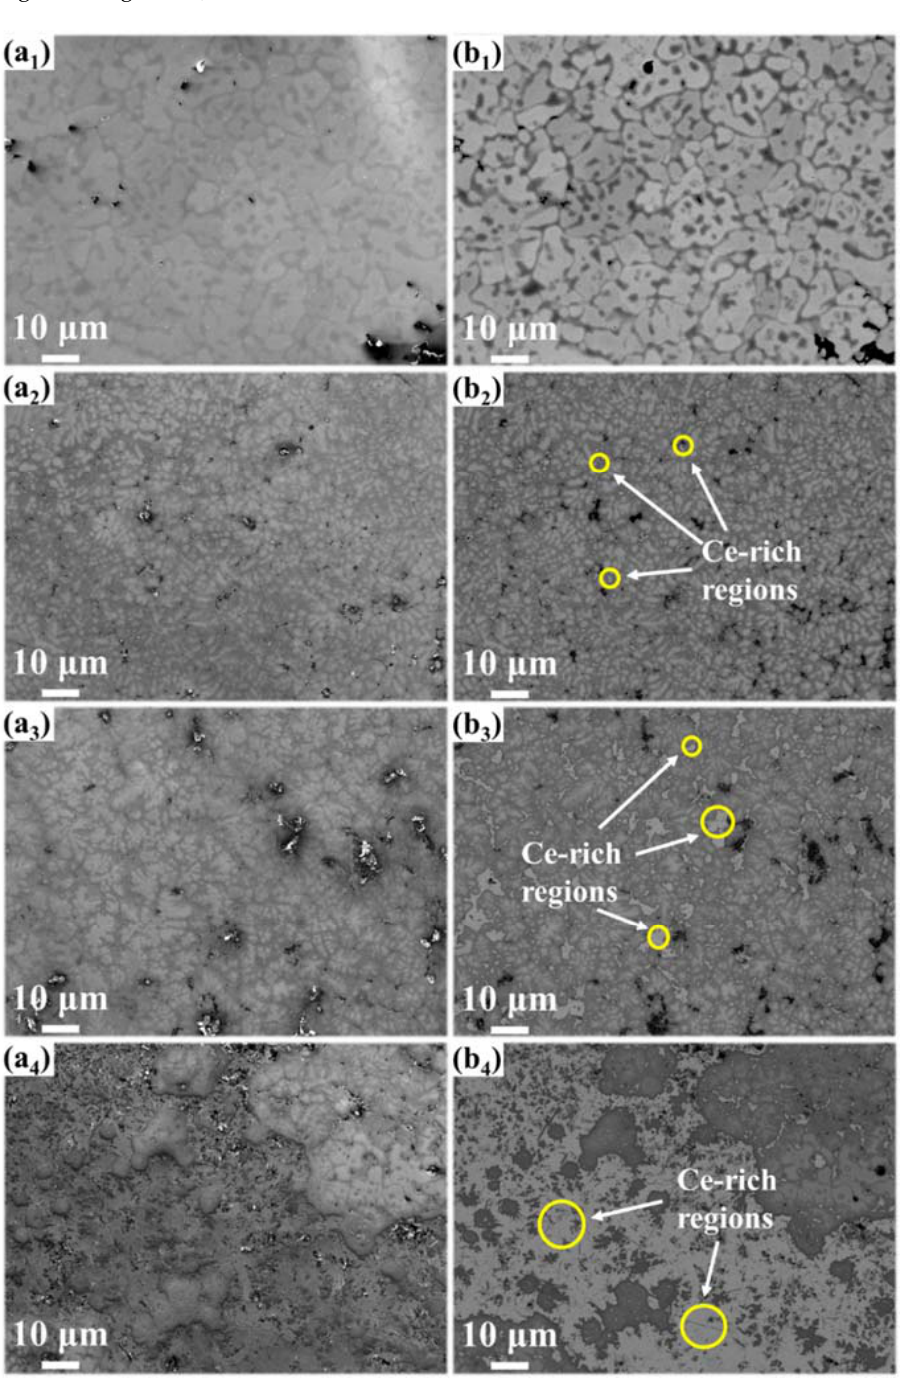
Figure 2. SEM ( left ) ‐ BSE ( right ) images of CeX: ( a 1 , b 1 ) Ce ‐ free; ( a 2 , b 2 ) Ce5; ( a 3 , b 3 ) Ce10; ( a 4 , b 4 ) Ce25.